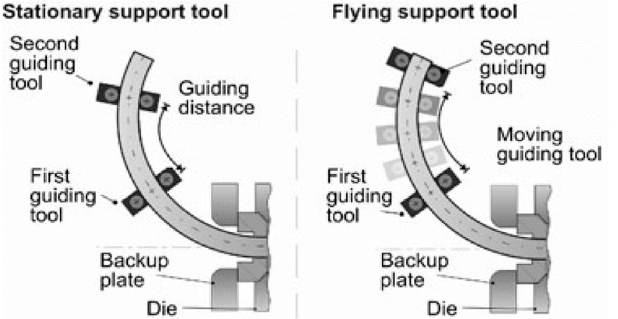
Figure 21. Flexible support for curved profile extrusion (CPE) [12,81,82]. Reproduced with permission from ref. [82]. Copyright 2015 Springer-Verlag Berlin Heidelberg.